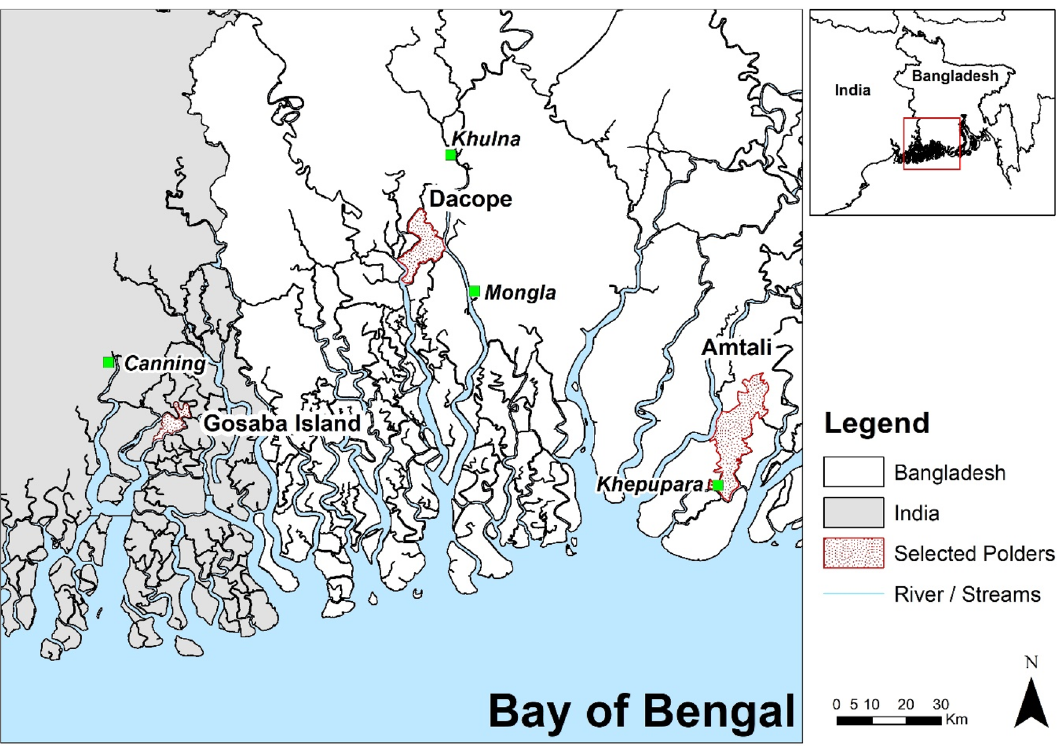
Figure 1. Study area map showing location of two polders (Amtali and Dacope) in Bangladesh and an island (Gosaba) in India (data source: https:// data. humda ta. org/ datas et/ bangl adesh- water- cours es).